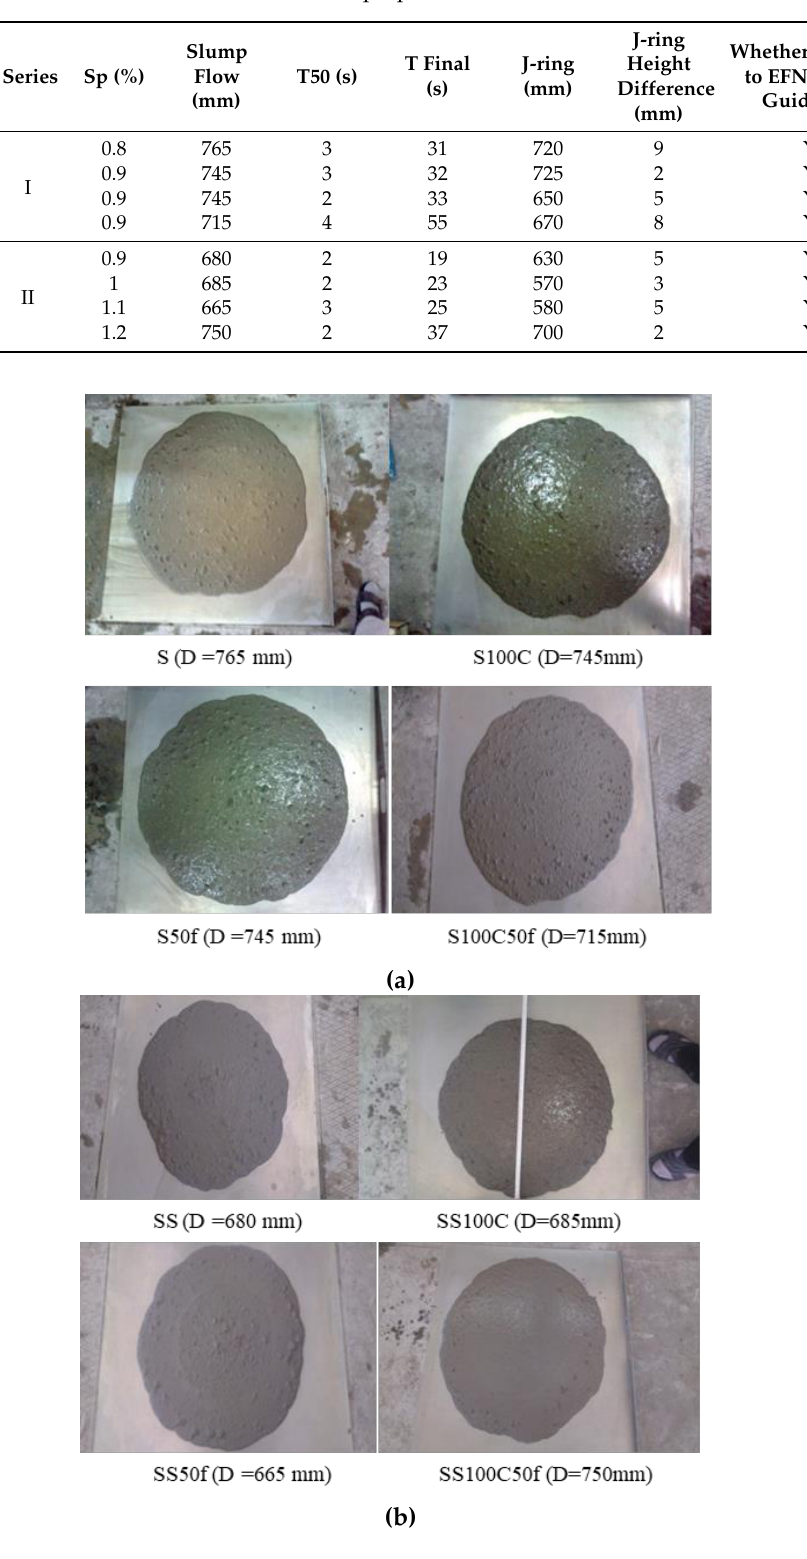
Figure 5. Slump flow tests ( a ) concrete mixtures series I, and ( b ) concrete mixtures series II.